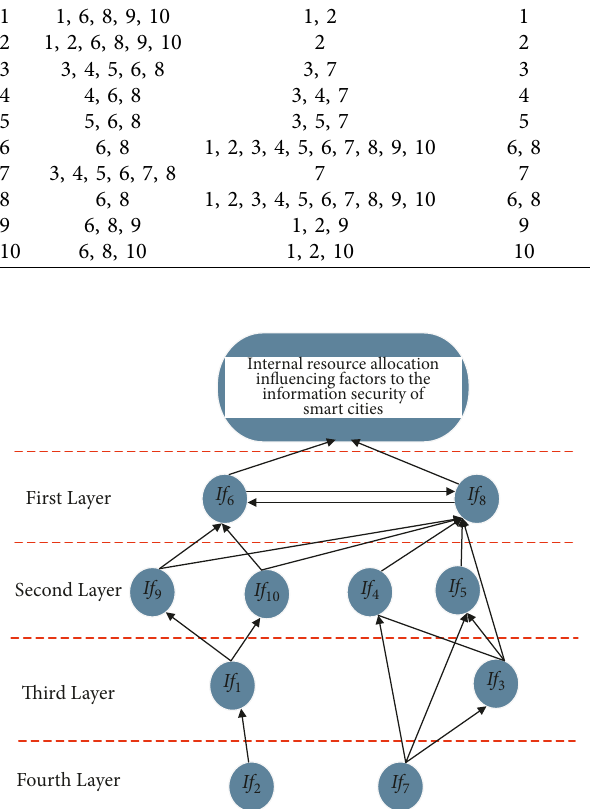
Figure 2: The interpretative structural model for factors influ- encing the internal resource allocation to information security in smart